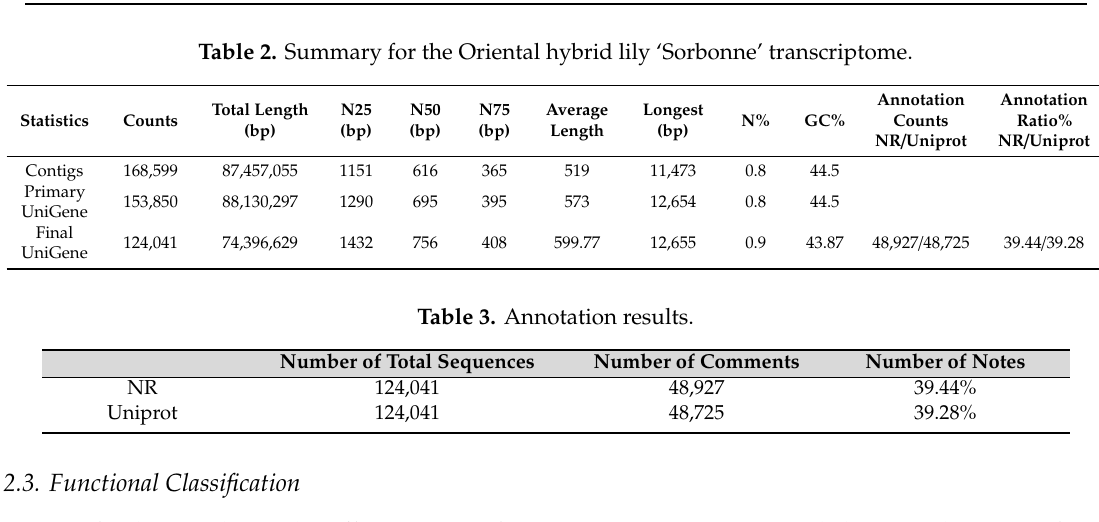
Table 2. Summary for the Oriental hybrid lily ‘Sorbonne’ transcriptome